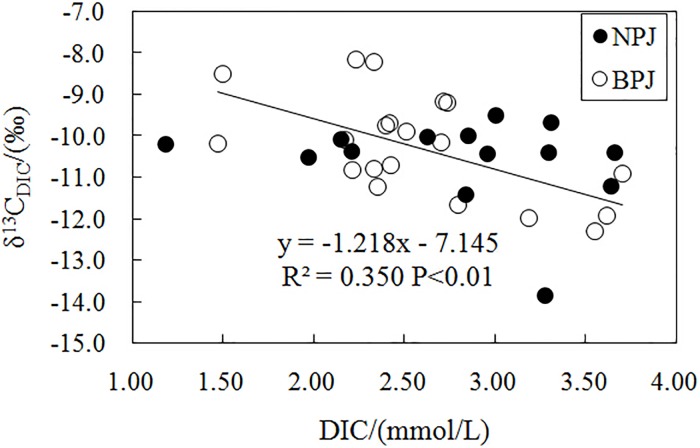
Correlation between DIC content and δ13CDIC.The trend line applies to data from the BPJ.